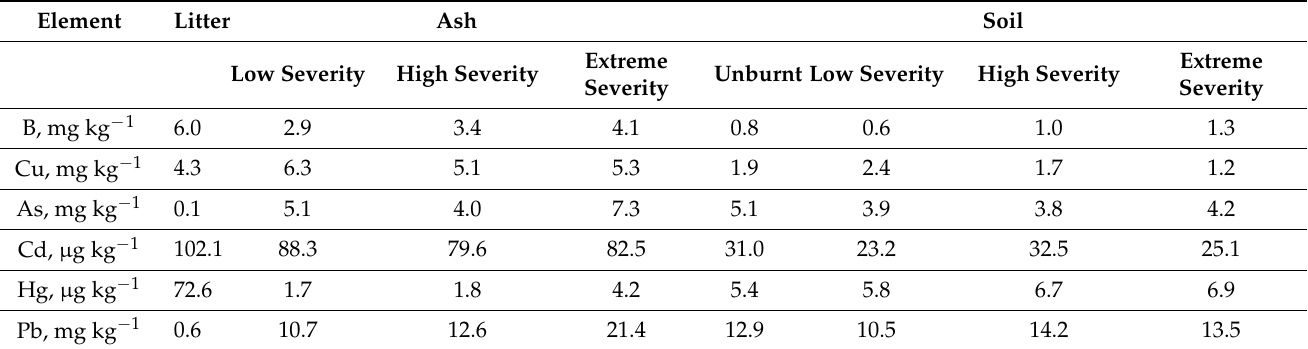
Table 8. Total concentrations of trace elements in litter (unburnt), ash, and soil (3–8 cm depth)